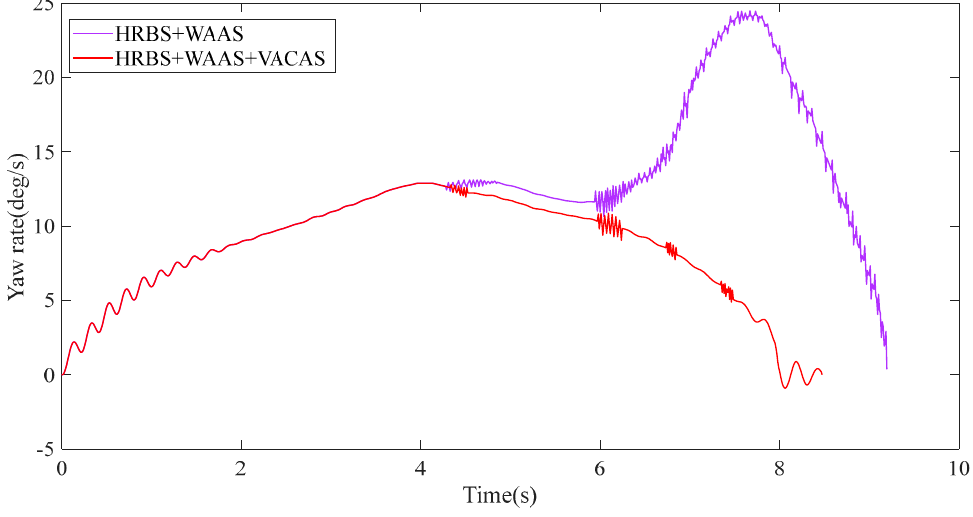
Figure 15. The variation curve of the yaw rate.